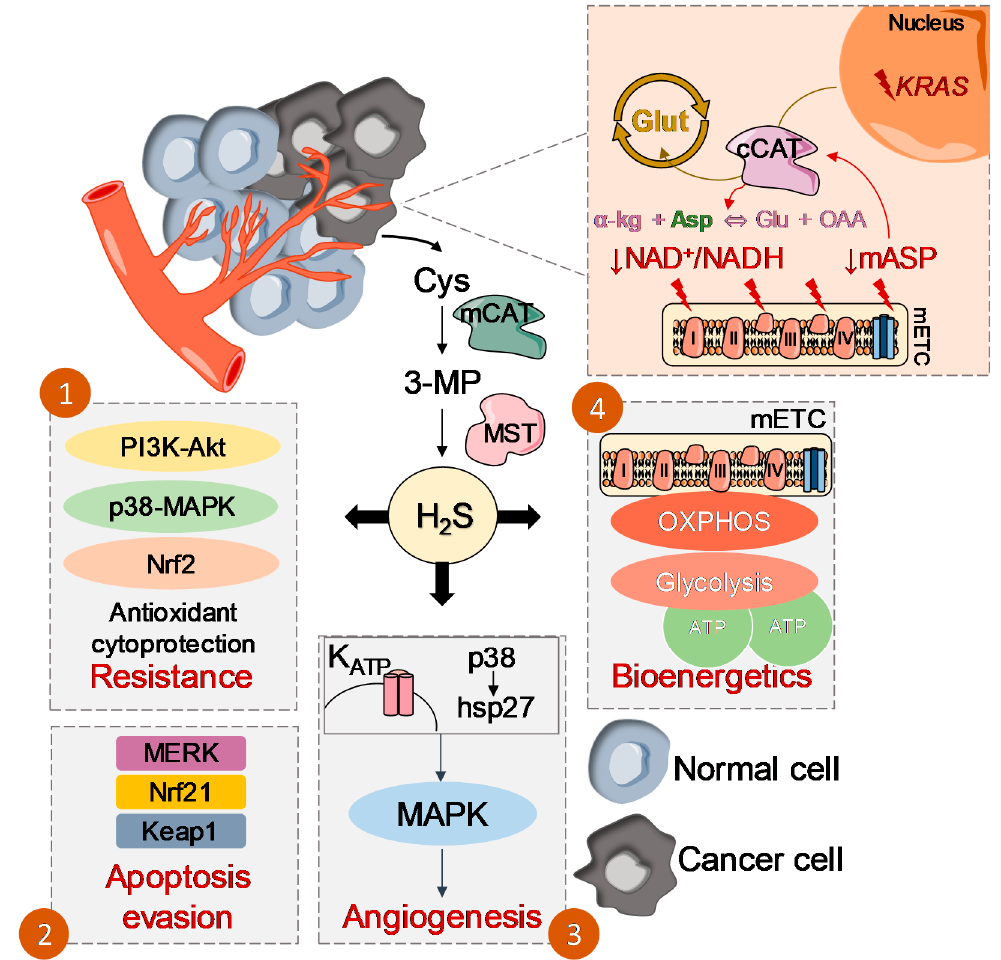
Figure 1. Role of the glutamate oxaloacetate transaminases:3-mercaptopyruvate sulfurtransferase (CAT:MST) axis in promoting and sustaining cancer. Cancer cells presenting defective mitochondrial electron transport chain (mETC) exhibit low levels of NADH/NAD + and mitochondrial aspartate (mAsp). These cells can take advantage of the reversible reaction catalyzed by cytoplasmic CAT (cCAT) (but not mitochondrial CAT (mCAT)), as observed in cancer cells with KRAS mutations, directing it to the production of Asp rather than its consumption, maintaining growth and survival. as a facilitator of cancer, probably due to multiple e ff ects of H 2 S: (1) cytoprotection and chemoresistance by stimulating phosphoinositide 3-kinases (PI3K)—protein kinase B (Akt), p3—MAPK and nuclear factor erythroid 2—related factor 2 (Nrf2) pathways; (2) evasion of apoptosis by stimulating